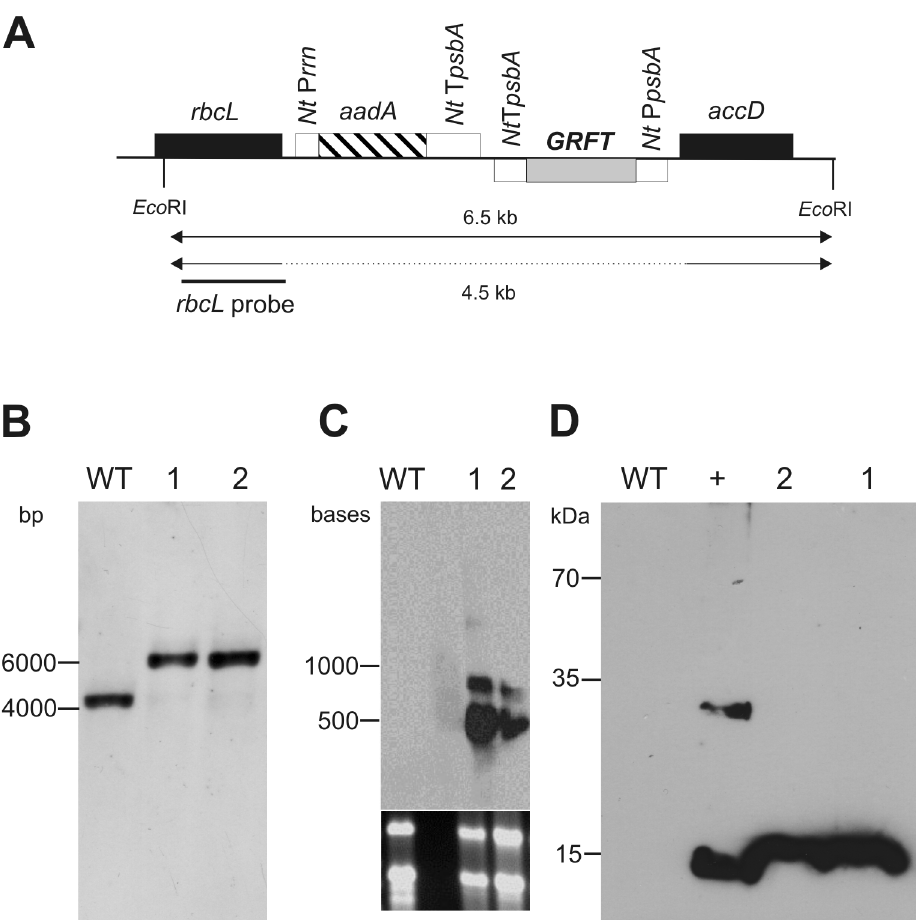
Figure 2. A) Schematic representation of the build-up of the expression construct used in this study (not drawn to scale). B) Restriction fragment length polymorphism analysis (RFLP) of the DNA isolated from wild type (WT) plants and two transplastomic lines (1 and 2). C) Northern blot analysis of the aforementioned lines. The lower panel shows total RNA, while the upper represents transcripts labeled with the griffithsin -specific probe. D) Western blot analysis of crude protein extracts of WT plants and two transplastomic lines (1 and 2). The blot was probed with an antibody directed against the hexahistidine tag. + represents an extract of a plant containing thioredoxin with a hexahistidine tag, serving as a positive control.